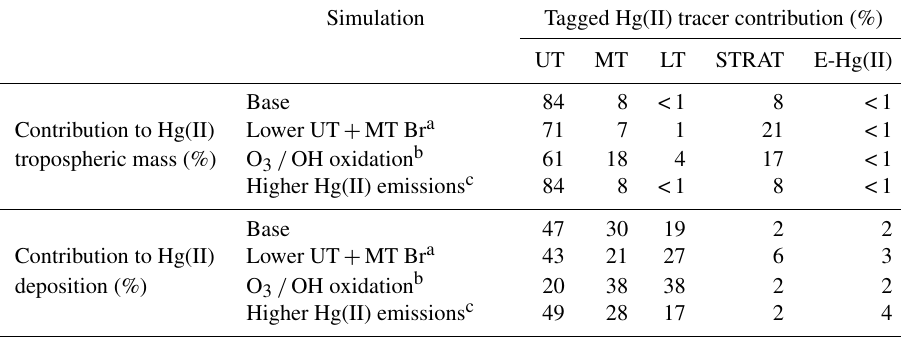
Table 2. Contribution of tagged Hg(II) tracers to the tropospheric mass and total deposition of Hg(II) for the base case and the sensitivity simulations.